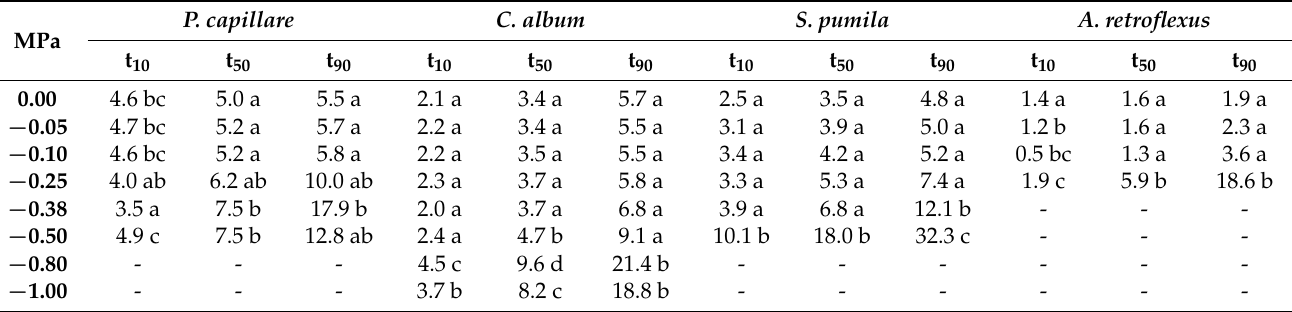
Figure 3. Estimated base temperatures. The solid line represents the linear regression line and the points represents the inverse value of the time necessary to reach 50% of germination (1/t 50 ).The estimated value of the base temperature is the intersection of the regression line with the x -axis: ( a ) Amaranthus retroflexus (T b = 13.9 ± 0.36 °C; y = 0.079x − 1.010; r 2 = 0.96); ( b ) Chenopodium album (T b = 3.4 ± 0.36 °C; y = 0.012x − 0.04, r 2 = 0.98); ( c ) Panicum capillare (T b = 11.0 ± 1.99 °C; y = 0.030x − 0.328; r 2 = 0.82); ( d ) Setaria pumila (T b = 6.6 ± 0.09 °C; y = 0.018x − 0.119; r 2 = 0.96) .